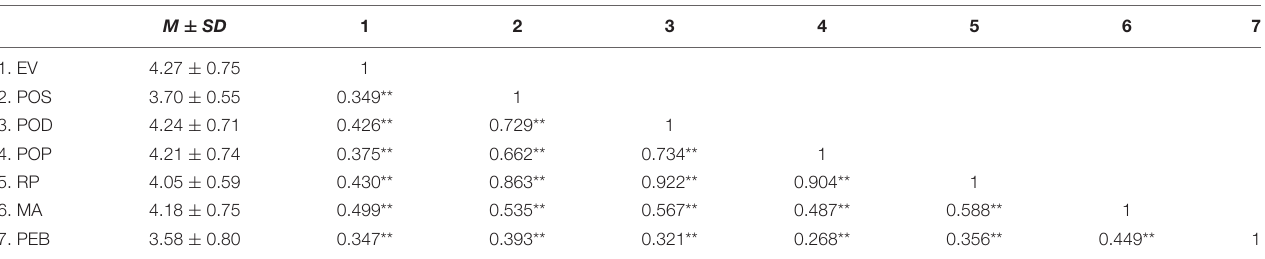
TABLE 1 | Descriptive statistics and Pearson correlations between the study